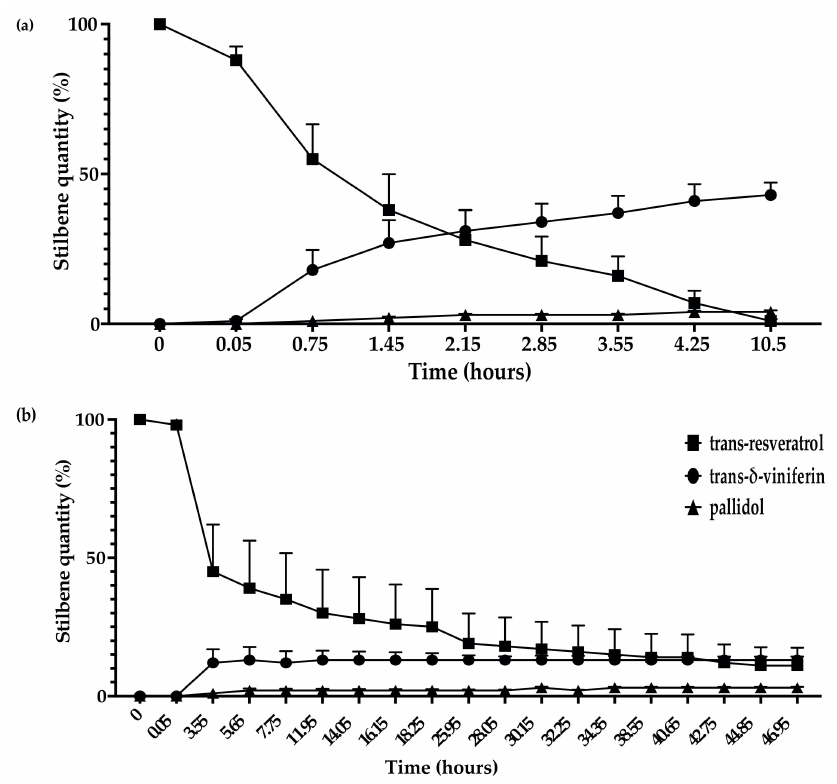
Figure 5. Kinetics of trans -resveratrol (5 µ g/mL) metabolization in sodium acetate buffer by total extracellular protein extract from ( a ) D. seriata (200 µ g/mL) and ( b ) N. parvum (1 mg/mL). Evolution of trans -resveratrol quantity is represented by square dots, trans- δ -viniferin is represented by circle dots, and pallidol is represented by triangle dots. Error bars represent the standard error of the mean (SEM). Mean and SEM were calculated with three biological replicates each comprising two technical replicates ( n =